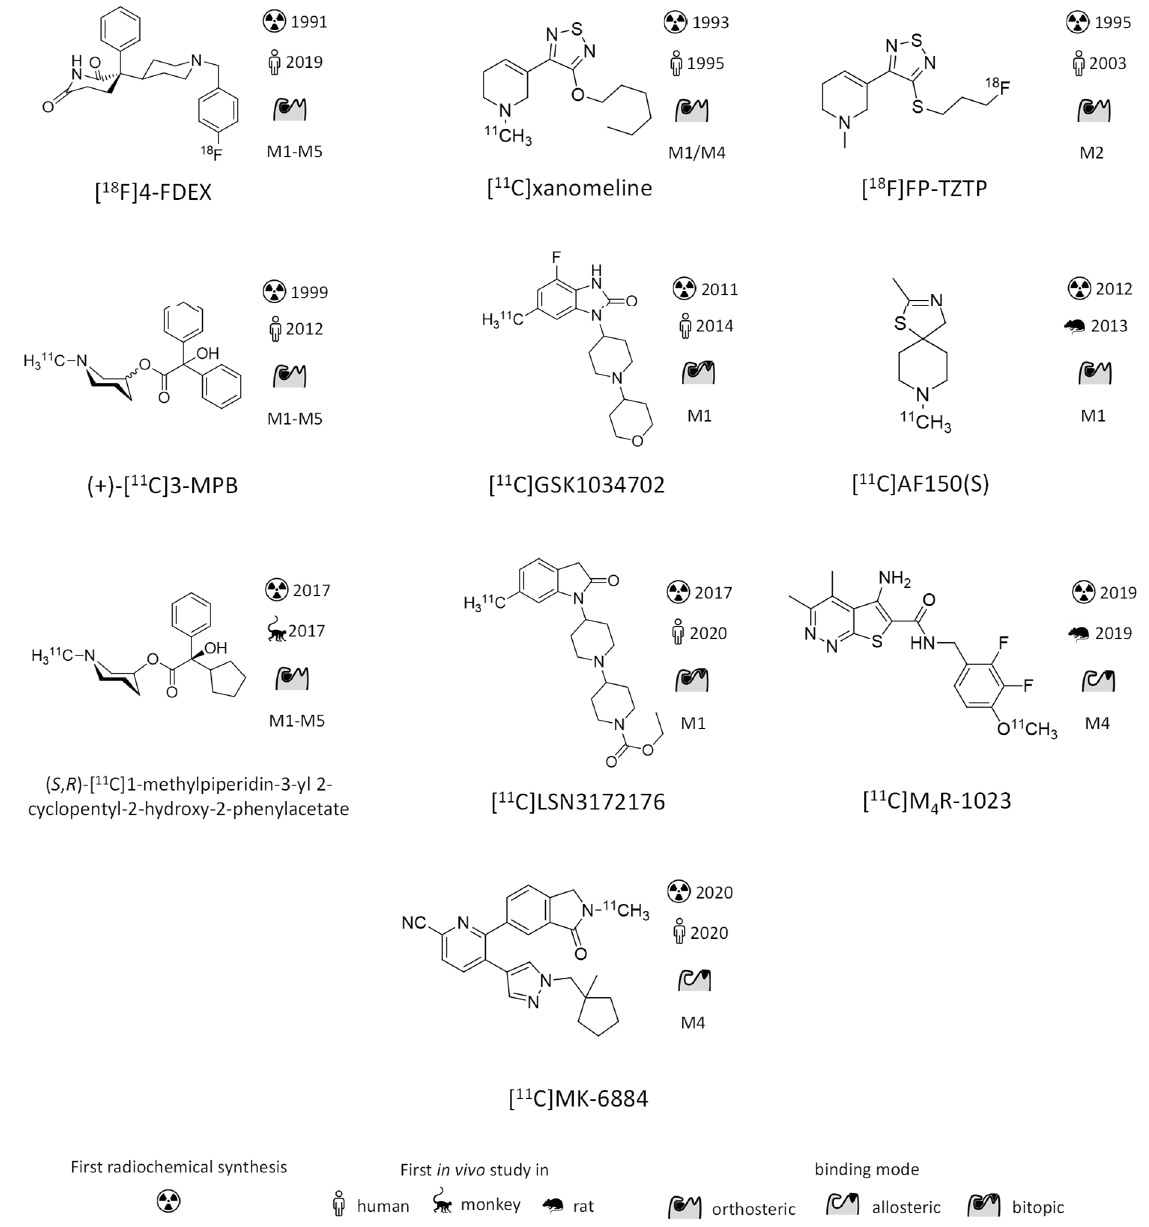
Figure 2. Structures and binding properties of mAChR ligands previously evaluated in vivo as imaging probes. Emphasis is given on novelties since the previous review in 2006 [5]. First synthesis: ( R , S )-[ 123 I]IQNB [100], [ carbonyl - 11 C]QNB [66],